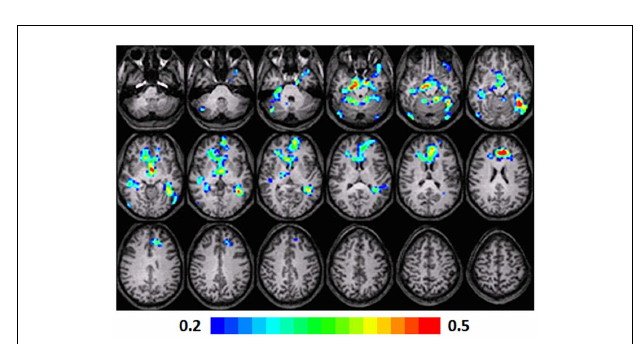
FIGURE 5 | Regression maps showing a positive correlation for activation during verb generation scans atT2 and the Letter–Word score from theWoodcock–Johnson III ( N = 16) fromT3. All activated pixels meet significance threshold of p < 001 uncorrected. Slices range from z = 7 to 24 in theTalairach frame. Cluster size is 35 voxels. Higher significance is indicated in hotter color ( r value ranged from 0.2 to 0.5). Figure is presented in a radiological orientation (L = R, R = L).